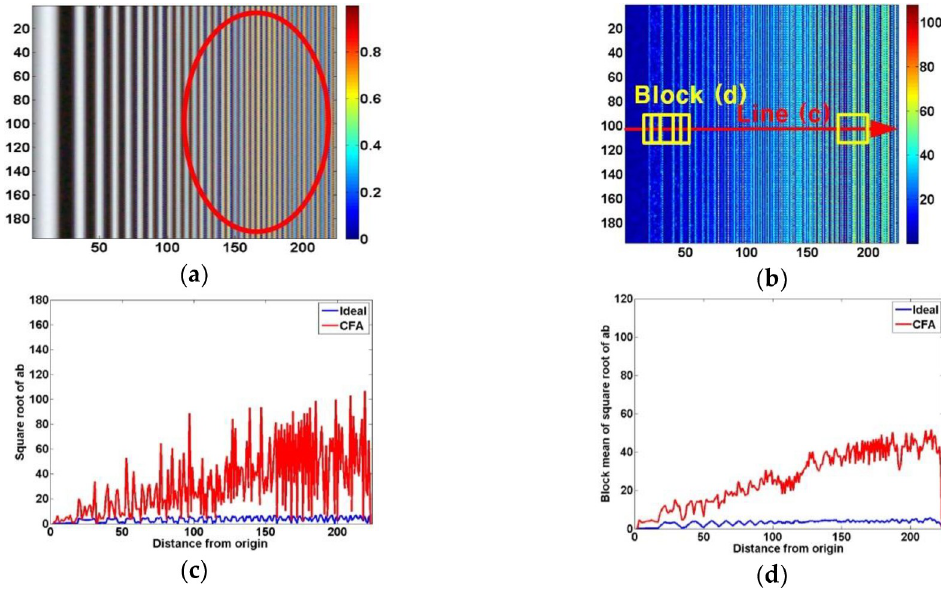
ffiffiffiffiffiffiffiffiffiffiffiffiffiffiffiffiffiffiffiffiffiffiffiffiffi q ð a � Þ 2 þ ð b � Þ 2 ) image for CFA output image,